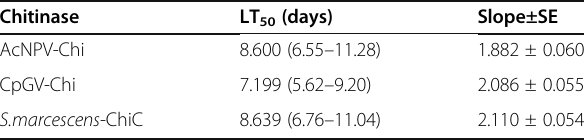
Table 2 LT 50 values of AcNPV-Chi, CpGV-Chi, and Serratia marcescens -ChiC proteins a Chitinase